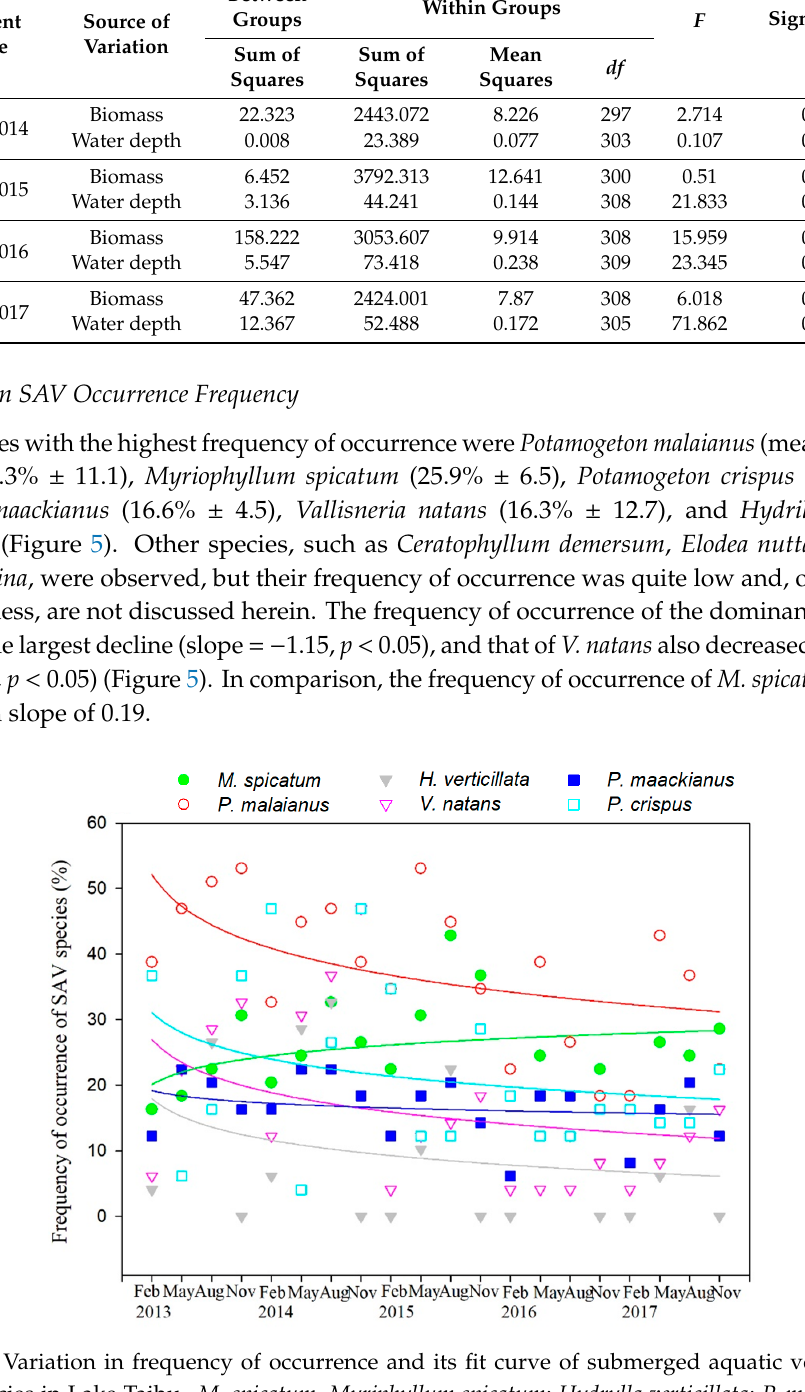
Figure 5. Variation in frequency of occurrence and its fit curve of submerged aquatic vegetation (SAV) species in Lake Taihu. M. spicatum , Myriphyllum spicatum ; Hydrylla verticillata ; P. maackianus , Potamogeton maackianus ; P. malaianus , Potamogeton malaianus ; P. crispus , Potamogeton crispus ; V. natans , Vallisneria natans Vallisneria natans .